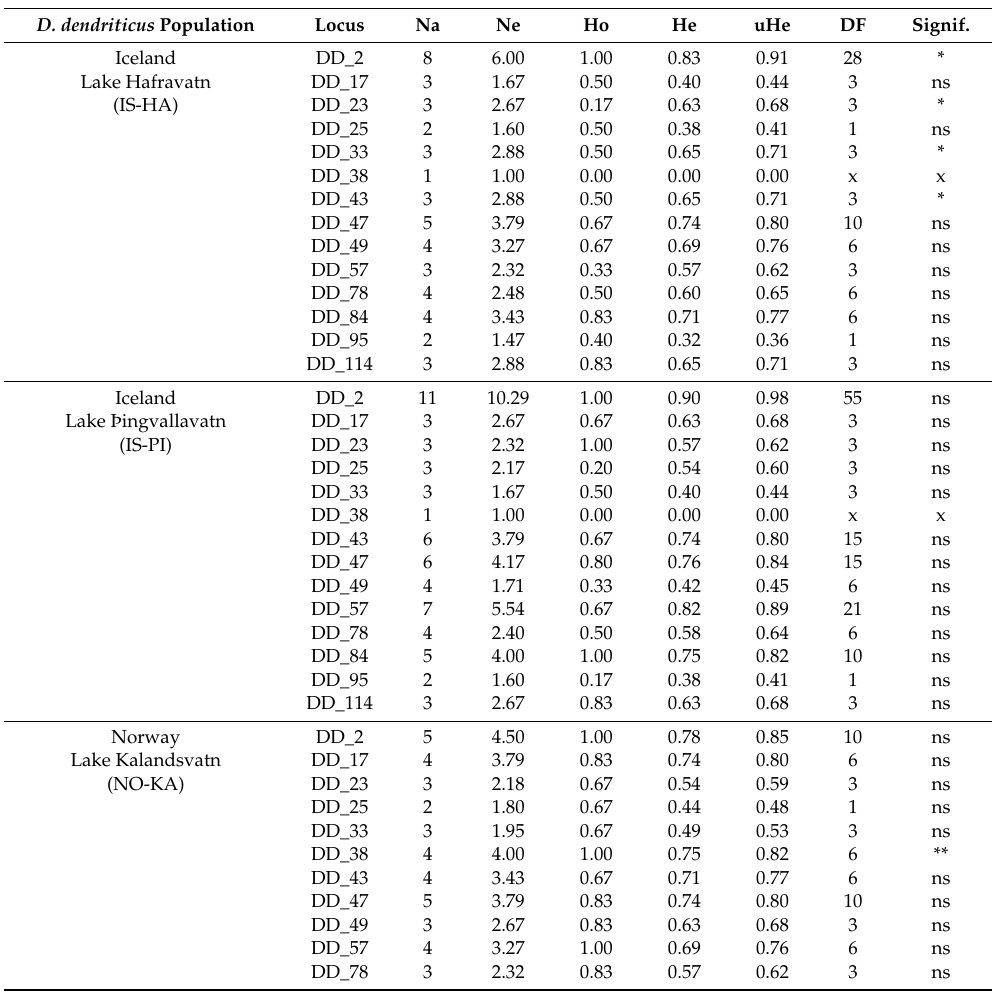
Table 3. Statistical data on 14 microsatellite markers validated in studied D. dendriticus populations. D. dendriticus